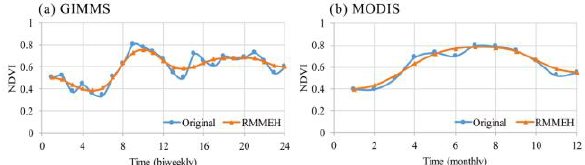
Figure S2. Schematic diagram showing the use of RMEEH to reduce the noise of time-series NDVI dataset. (a) one-year GIMMS data with a biweekly interval; and (b) one-year MODIS data with a monthly interval. The blue lines are original NDVI while the orange ones are the filtered NDVI using RMMEH. Results show that RMMEH efficiently reduces noise of NDVI time series while preserving accurate temporal profiles.